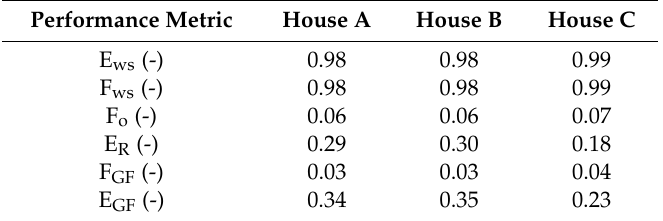
Table 4. Long-term water supply and stormwater management performance for current